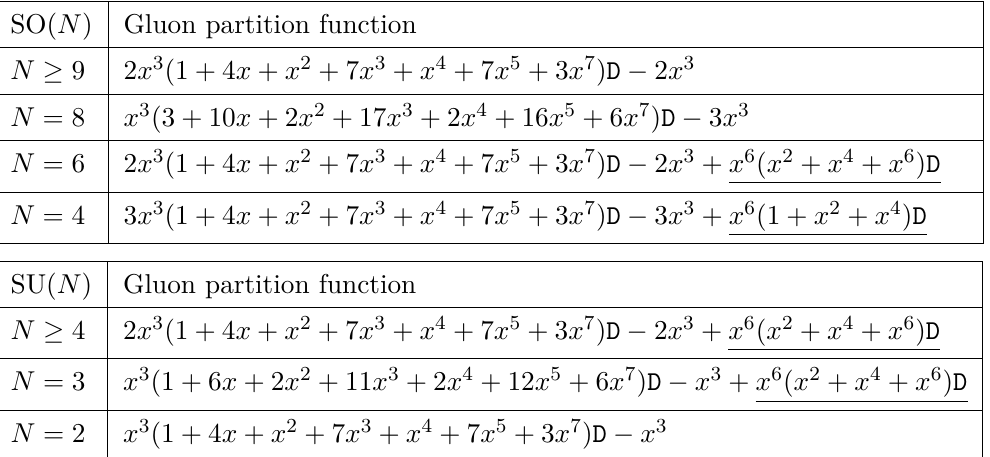
Table 5 . Partition function over the space of Lagrangians in D = 7 involving four F a D ≡ 1 / ((1 − x 4 )(1 − x 6 )) . Contribution of M non-inv is underlined. The rest is the contribution of M inv . Partition function for SO(5) and SO(7) is the same as that for SO( N ) for N ≥ 9 .